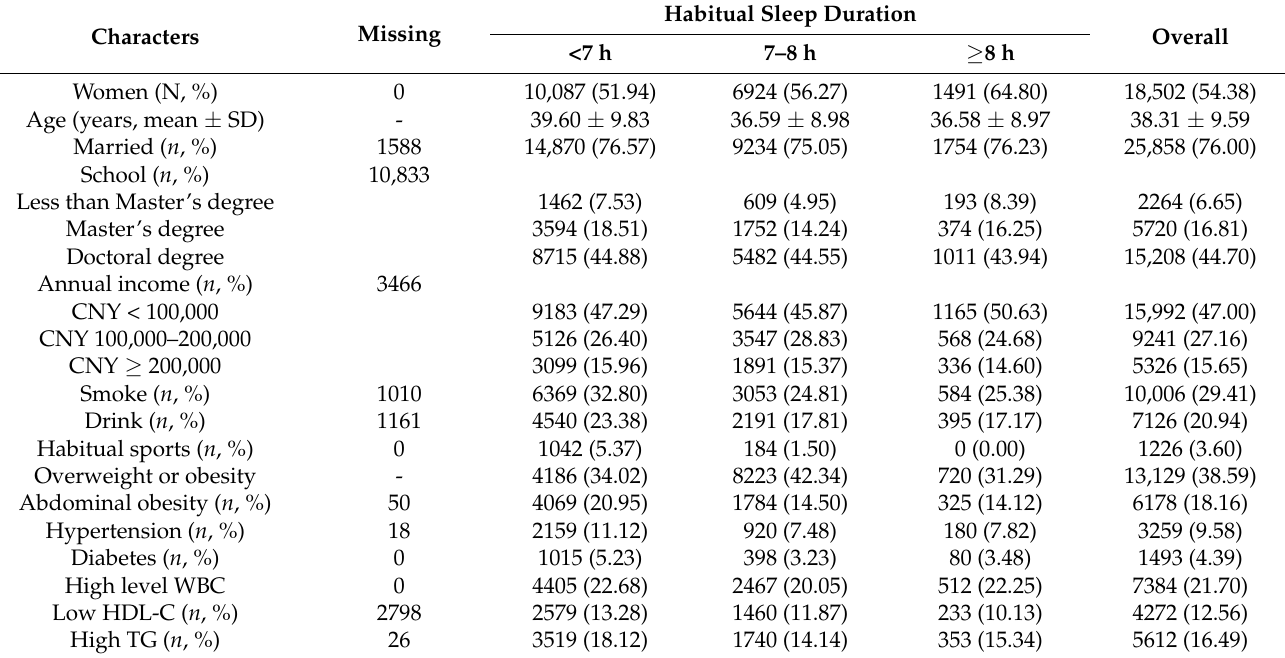
Table 1. Baseline characteristics of participants by sleep